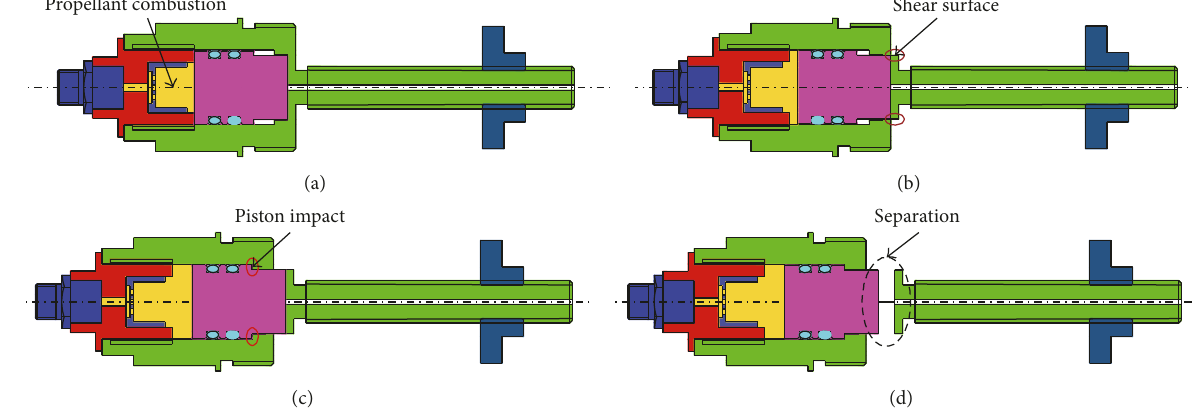
Figure 2: Schematic diagrams of separation mechanism for shear type explosive bolt: (a) step 1, (b) step 2, (c) step 3, and (d) step 4.